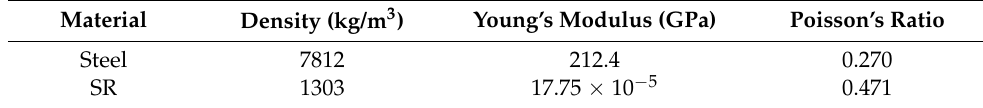
Table 3. Materials’ parameters used in the experiment.